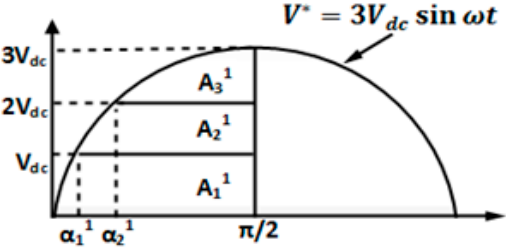
Figure 9. Reference voltage waveform with dummy conducting angles.